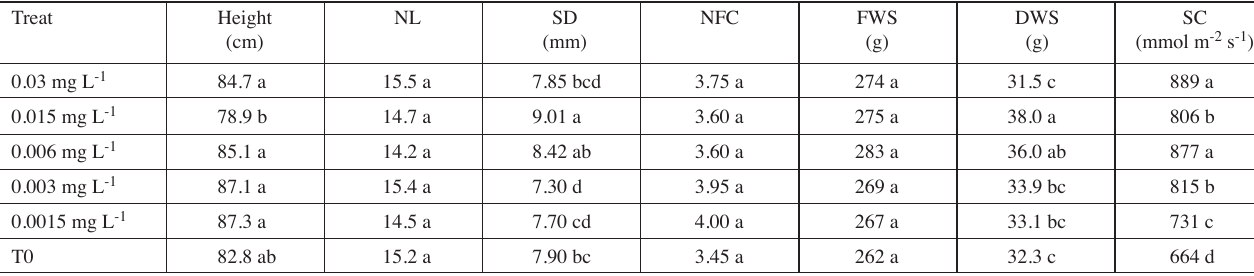
Tab. 1: Morphological variables of tomato plants treated with nCu-chitosan hydrogel.